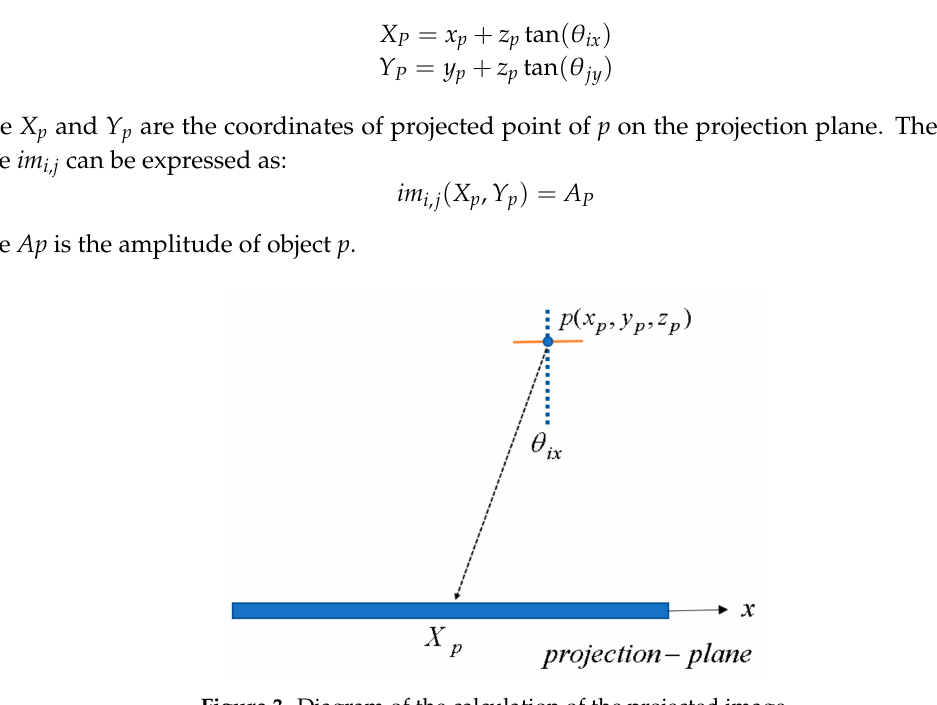
Figure 3. Diagram of the calculation of the projected